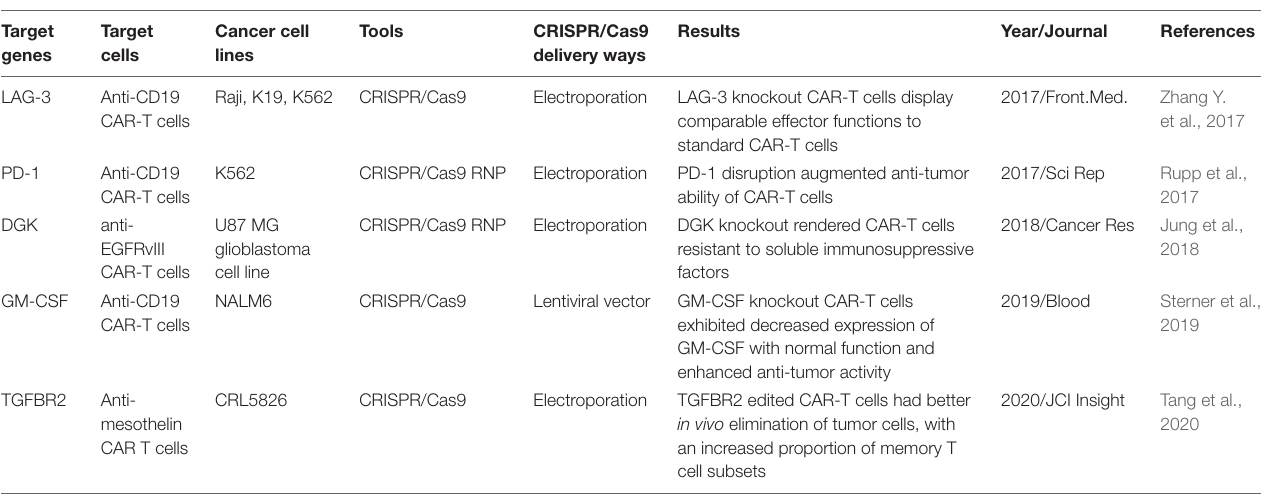
TABLE 2 | Representative targets of CAR-T cells engineered by CRISPR/Cas9 system. Target